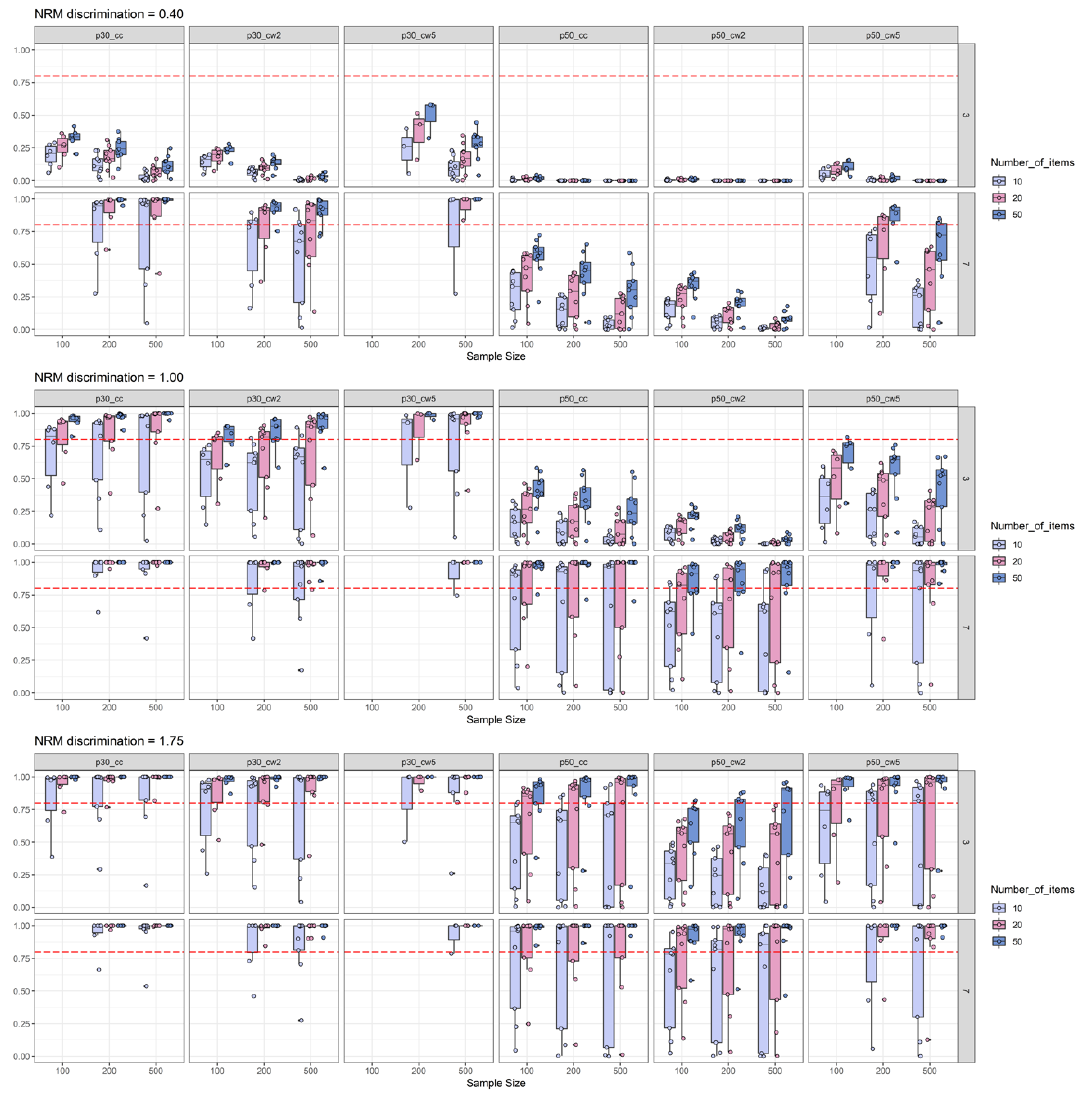
Figure 3. Number-of-items split of empirical power analysis: Depiction of the empirical power (y-axis) as a function of NRM discrimination (0.40 = top-row; 1.00 = middle-row; and 1.75 = bottom-row), sample size (x-axis), number of distractors (three distractors = top-row in each sub-plot; seven distractors = bottom-row in each sub-plot), number of items, and effect size measures combined with effect size thresholds. The horizontal red dashed line represents the target power level of 0.80. For more explanations, see Figure 2.